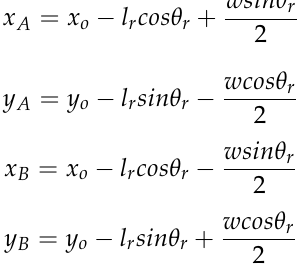
Figure 7. The geometric movement state of vehicles. The OBB of the articulated vehicles ( Polygon car ) can be represented by polygon ABCDEFG . According to the geometric relationship, the coordinates of each point of Polygon car can be expressed as the formulas